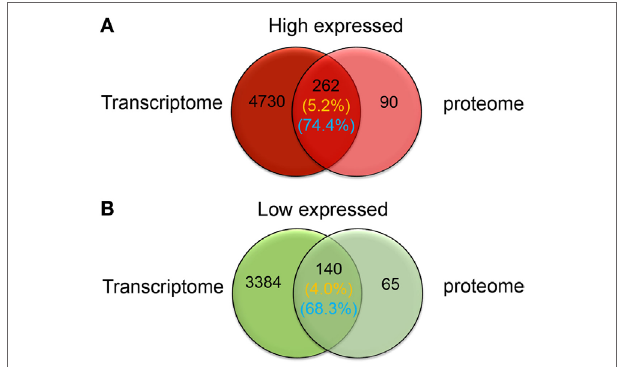
FigUre 5 | Venn-regional analysis of phagocyte differentially expressed genes and differentially expressed proteins. These diagrams illustrate overlap between significantly high (red) and low expressed (green) genes and proteins. Transcriptomic and quantitative proteomic analyses reveal a total of 4,992 genes and 352 proteins that are significantly high expressed in phagocytes (a) , and 3,524 and 205 that are significantly low expressed, respectively (B) . The percentages of overlapping high and low expressed molecules at messenger RNA and protein levels are indicated on this figure and are labeled with yellow and blue colors,